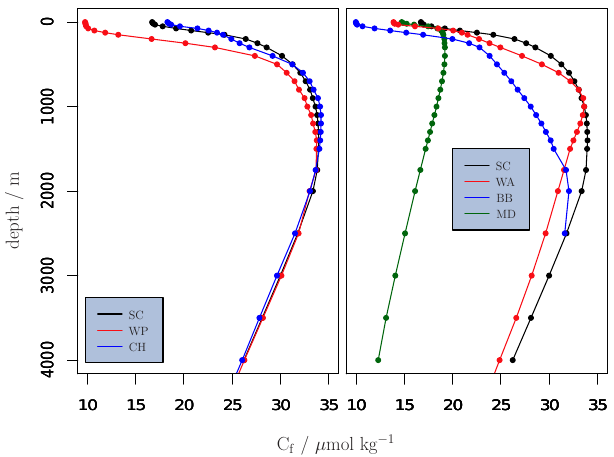
Fig. 6. Minimal oxygen concentration C f , supporting a given laboratory-determined oxygen uptake rate, depth profiles of the wa- ter column at different hydrographical stations around the world (SC: Southern California (120.5 ◦ W, 29.5 ◦ N); CH: Chile (75.5 ◦ W, 33.5 ◦ S); WP: Western Pacific (126.5 ◦ E, 11.5 ◦ N), WA: Western Africa (6.5 ◦ E, 15.5 ◦ S), MD: Mediterranean (18.5 ◦ E, 35.5 ◦ N); BB: Bay of Bengal (87.5 ◦ E, 18.5 ◦ N))). A generic flow velocity of u 100 =2cms − 1 is assumed for all depths to calculate L . If avail- able, detailed flow profiles can be used here, as well as organism- specific descriptions for L . For all calculations we assume a